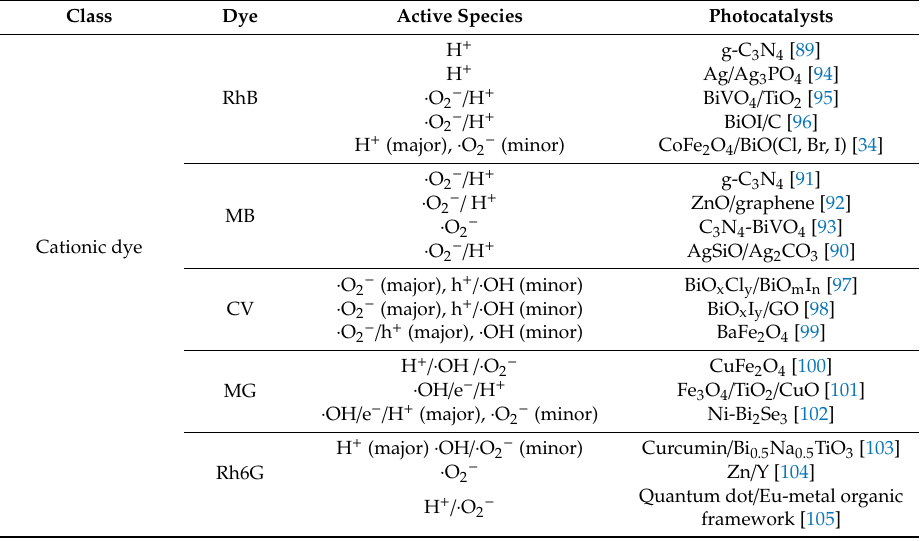
Table 3. Active species for photodegradation of commonly reported dyes